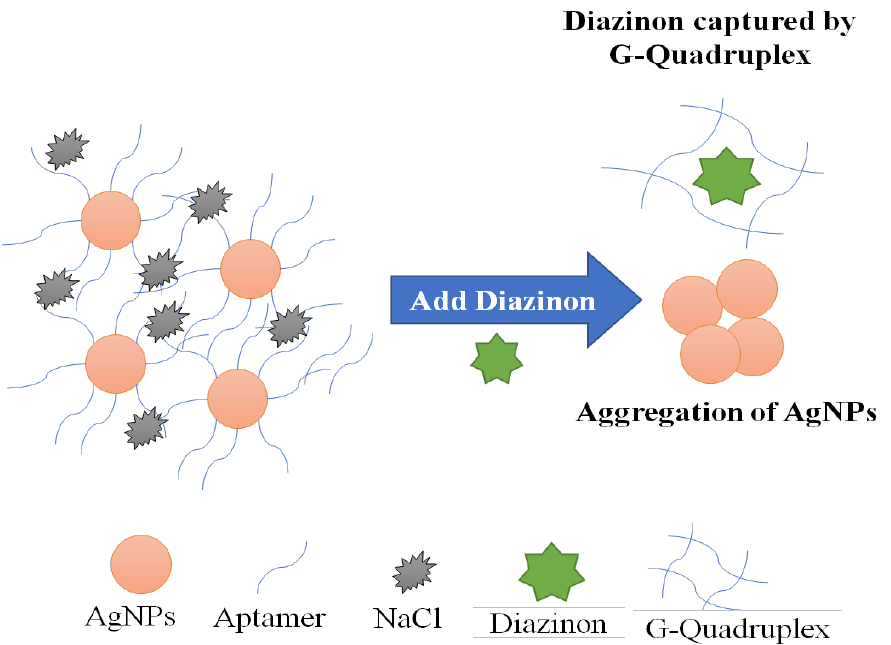
Figure 8. A schematic representation of the principle of Diazinon colorimetric aptasensing. Adapted from Jokar et al . [153].